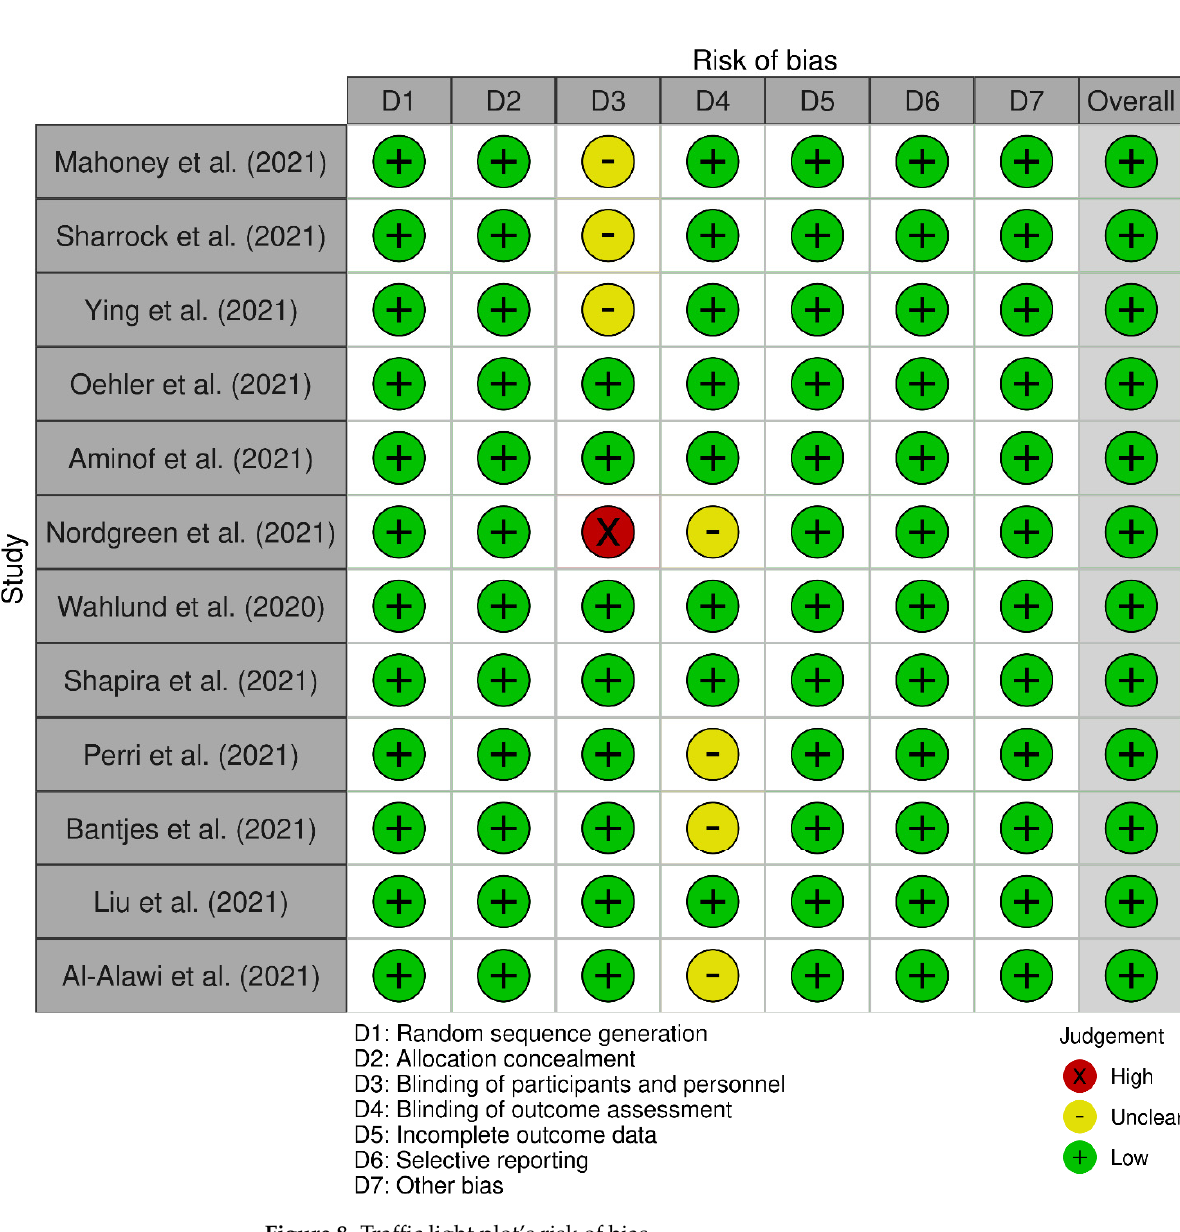
Figure 8. Traffic light plot’s risk of bias.